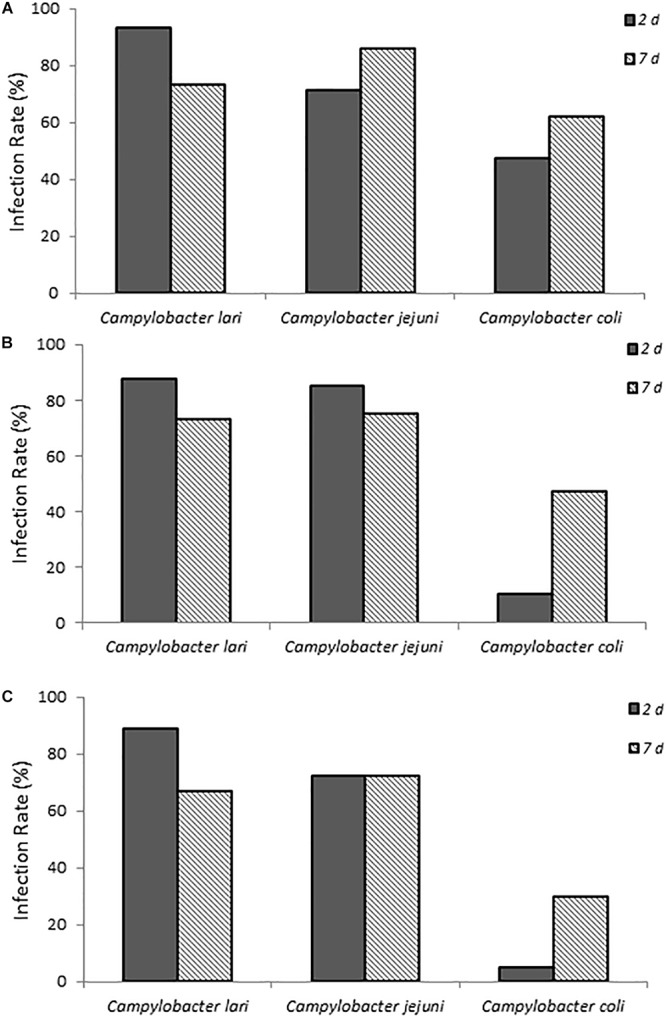
Infection rates of laboratory isolates of Campylobacter spp. (A–C) show chicks infected with dose A, B, and C Campylobacter spp., respectively. Percent infected was determined by dividing the number of infected chicks by the total number of chicks inoculated with the various Campylobacter species. Chicks were considered infected if fecal samples collected at the various times were positive for Campylobacter spp. as determined by using the passive-filter plating described in section “Materials and Methods.”